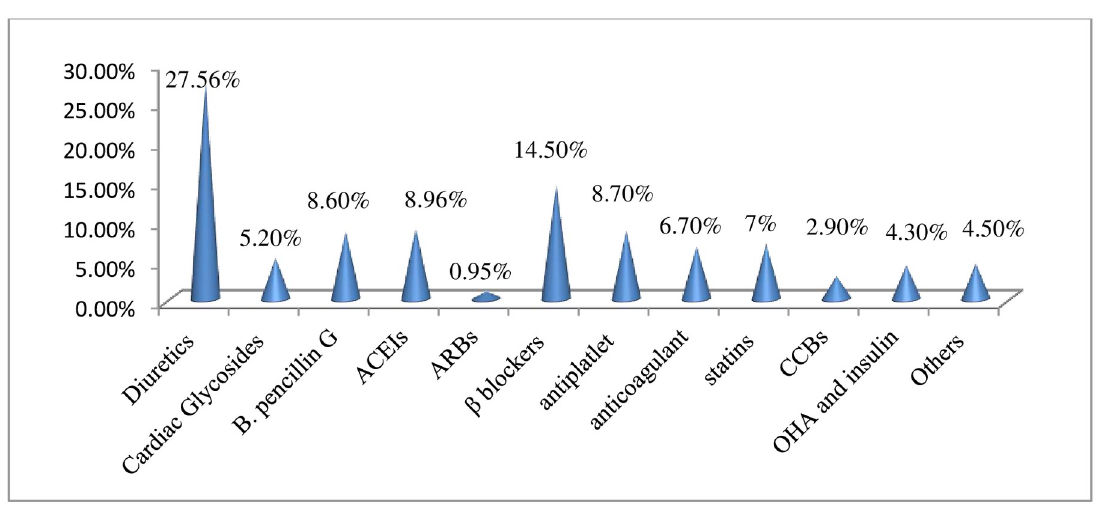
Fig 2. Frequently prescribed drug class in heart failure patients attending at the cardiac clinic of Tikur Anbessa Specialized Hospital, Addis Ababa, Ethiopia June-August, 2017. Anti arrhythmic, antianginal agent, antithyroid, antiTB, HAART, Iron salt, NSAIDs, xanthine oxidase inhibitor, tricyclic antidepressant; ACIEs: angiotensin converting enzyme inhibitors, ARBs: angiotensin receptor blockers, CCBs: calcium channel blockers, OHA: oral hypoglycemic agents.